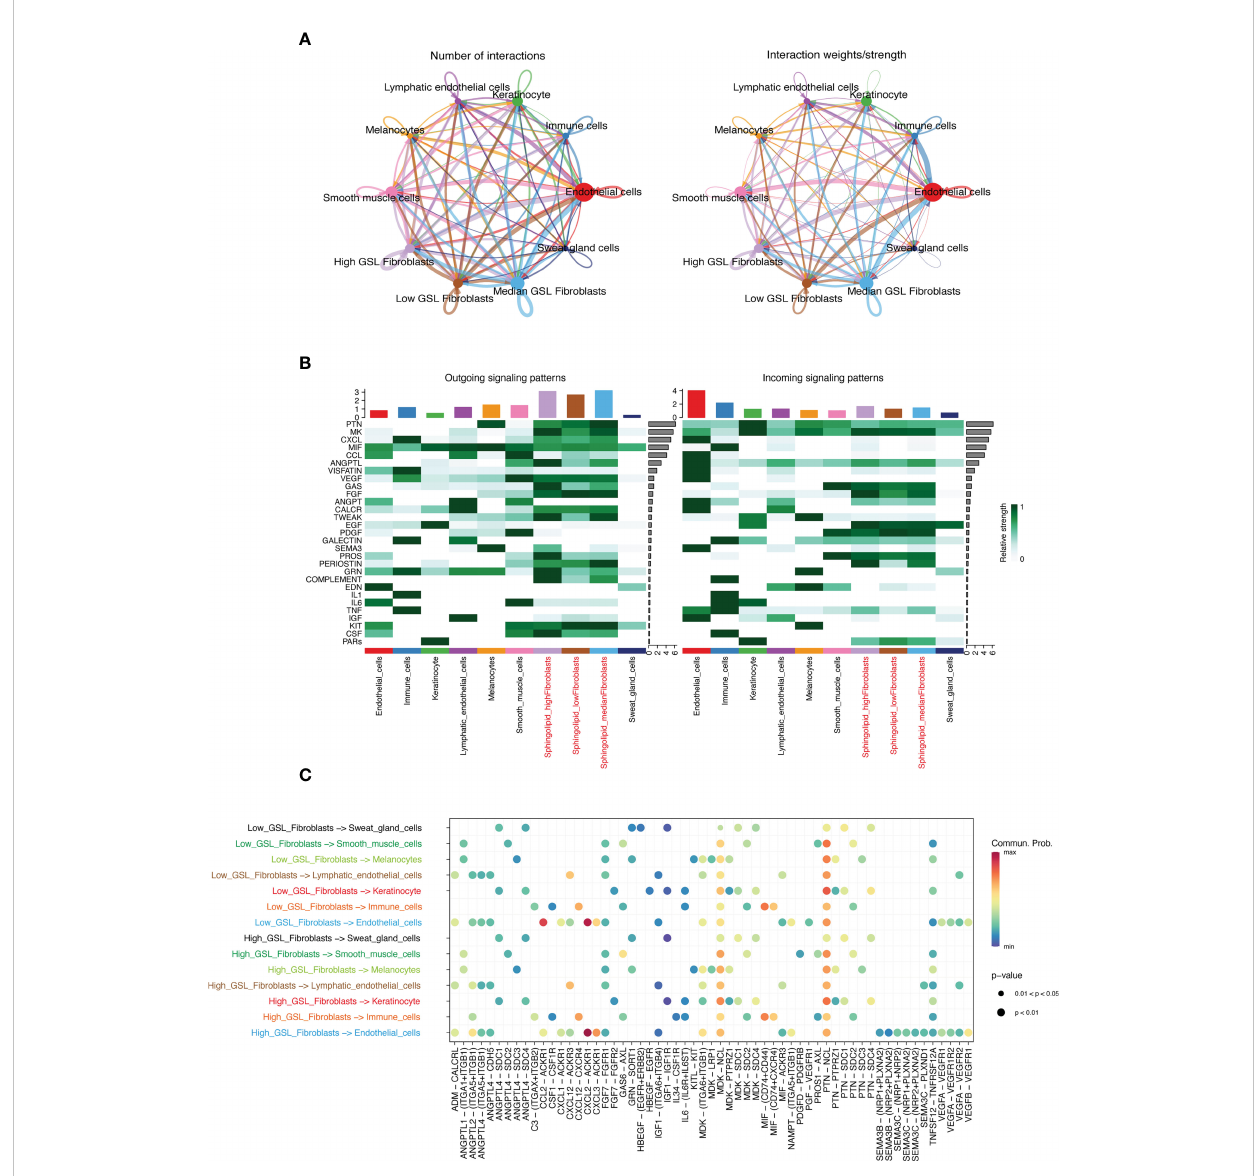
FIGURE 9 (A) Integrated cell-cell communication networks drawn by number and weight of interactions. (B) The heatmap of outgoing/incoming interaction strength for 10 cell types. (C) The dot plot of outgoing and incoming interaction signal pathways for fi broblasts of two